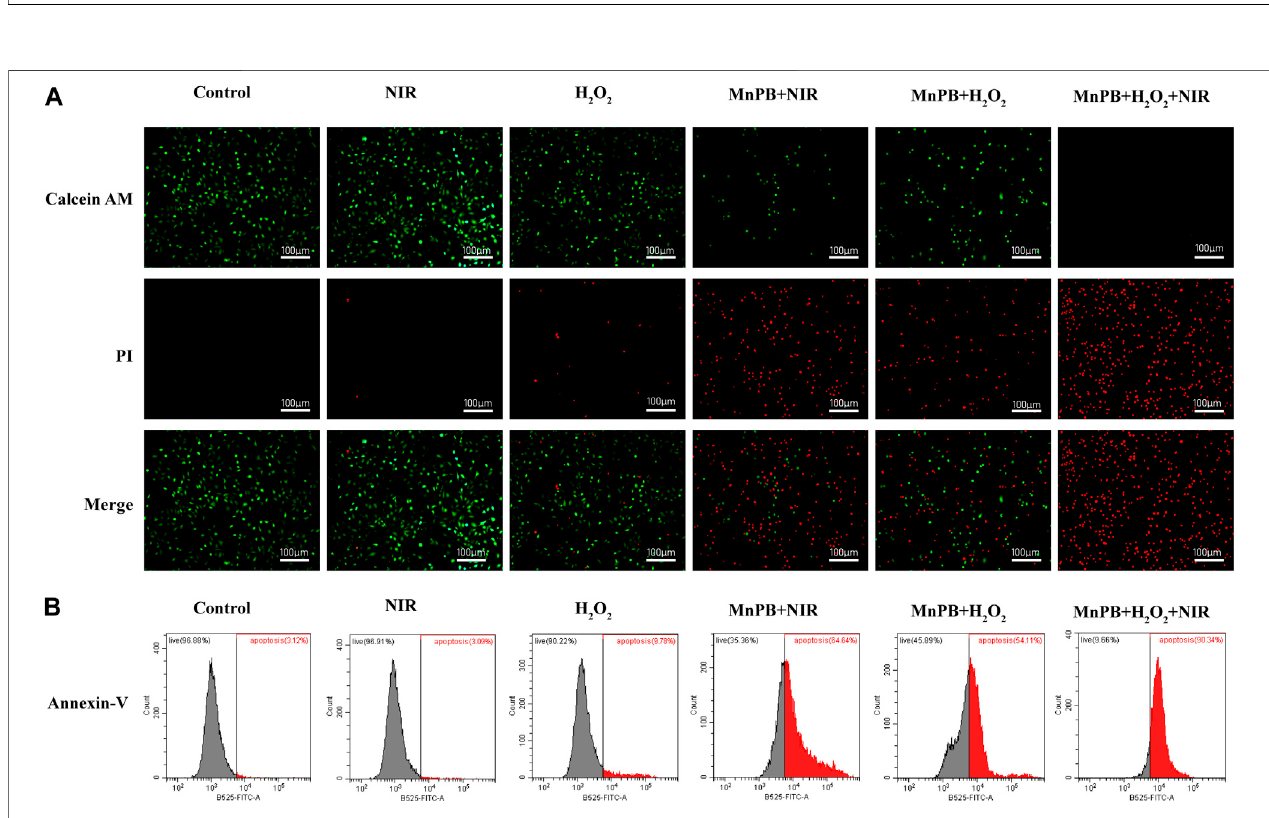
FIGURE 5 | The MnPB NPs can induce cell apoptosis by ROS upregulation and NIR irradiation. (A) Confocal images of A549 cells stained with Calcein-AM and PI after different treatments. Scale bar, 100 μ m. (B) Flow cytometry analysis of cell apoptosis with Annexin V-FITC staining.